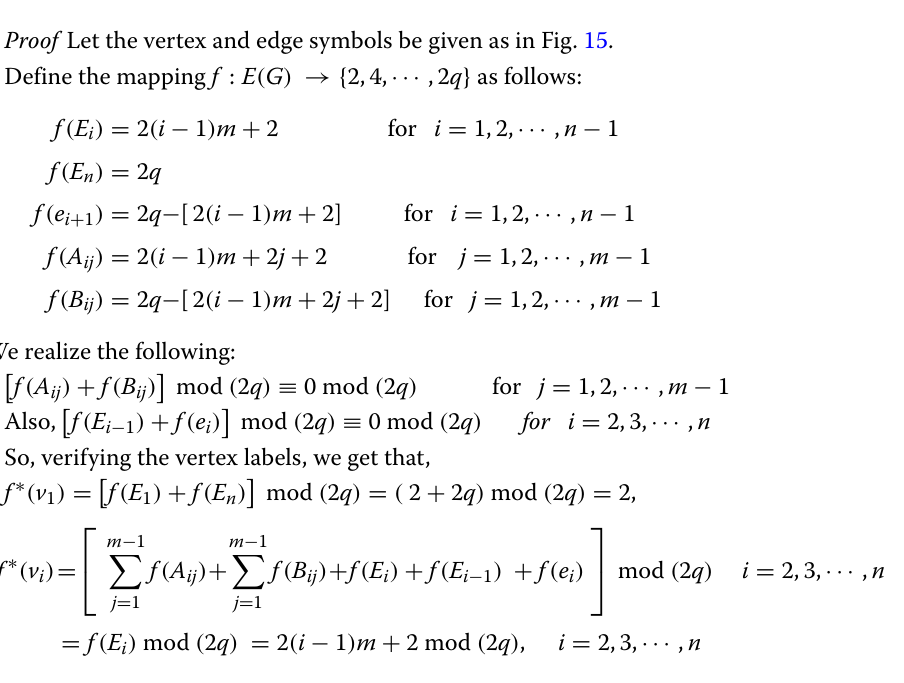
Illustration: In Fig. 16, we present an edge even graceful labeling of the graph { C 6 − }} (cid:4) K { v 1 3